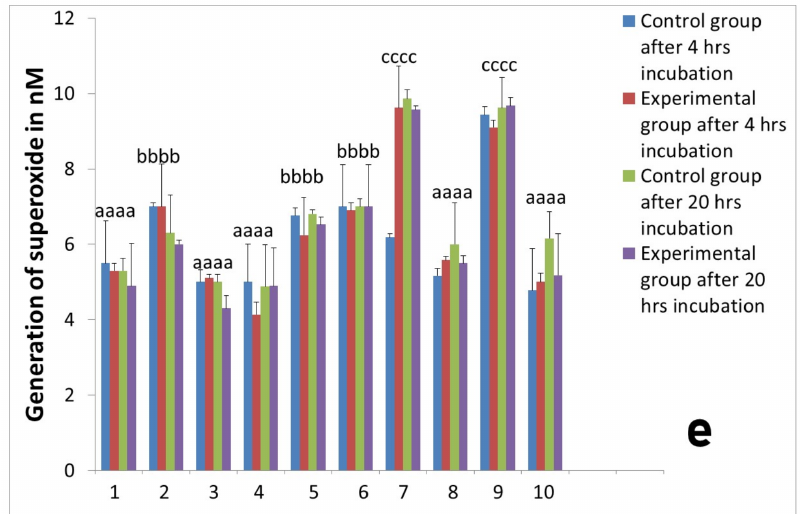
Figure 5. The response of neutrophils isolated 24 h after implantation with different PRP-derived products with or without additional stimulation with LPS. Cultures were incubated for 4 h or for 20 h at 37 ◦ C and 5% CO 2. Data present mean values ± SE of at least three replicates for each bar. The neutrophil response was assessed with respect to: ( a ) elastase release from neutrophils, ( b ) MPO release, ( c ) ALP release, ( d ) NO generation, ( e ) superoxide generation. Values marked with different letters differed significantly ( p < 0.05). Legends: 1—neutrophil without stimulation, 2—after stimulation LPS, 3—after stimulation PPP from L-PRP, 4—after stimulation PPP from PURE PRP, 5—after stimulation PPP from L-PRP with LPS, 6—after stimulation PPP from PURE PRP with LPS, 7—after stimulation L-PRP, 8—after stimulation PURE PRP, 9—after stimulation L-PRP with LPS, 10—after stimulation PURE PRP with